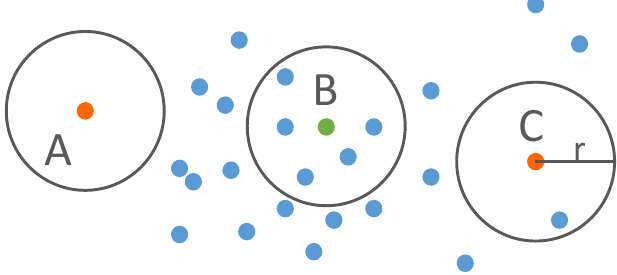
Figure 2. The principle of point cloud denoising. After denoising, the ground points are extracted by using progressive TIN densifica- tion filtering [32] and the basic idea is described as follows: (1) The point cloud is divided into a grid according to the maximum building size in the scene. (2) The lowest point in the grid is selected as the ground seed point, the other ground points are iteratively added by using the progressive TIN densification filtering and the iteration terminates when no other points are added to the TIN. The schematic diagram of the densified TIN is shown in Figure 3a. Figure 3b shows the densification process of a triangle of three ground points. In Figure 3b, the unclassified points are identified as ground points when iterative d and iterative β are less than the corresponding threshold.